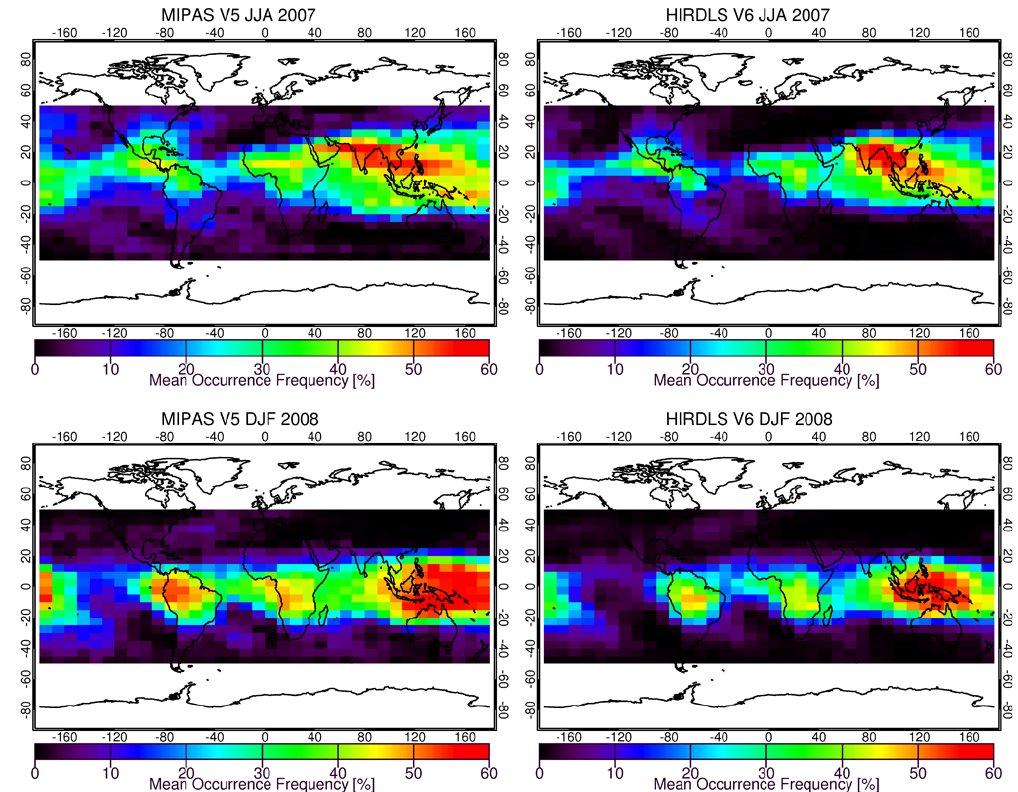
Fig. 6. MIPAS and HIRDLS mean OF for JJA 2007 and DJF 2007/2008 in the range of 12km to 20km (binned on a 1km vertical grid) between 50 ◦ N and 50 ◦ S on a 5 ◦ latitude and 10 ◦ longitude grid. Top left: MIPAS JJA 2007, top right: HIRDLS JJA 2007; bottom left: MIPAS DJF 2008 and bottom right HIRDLS DJF 2008.